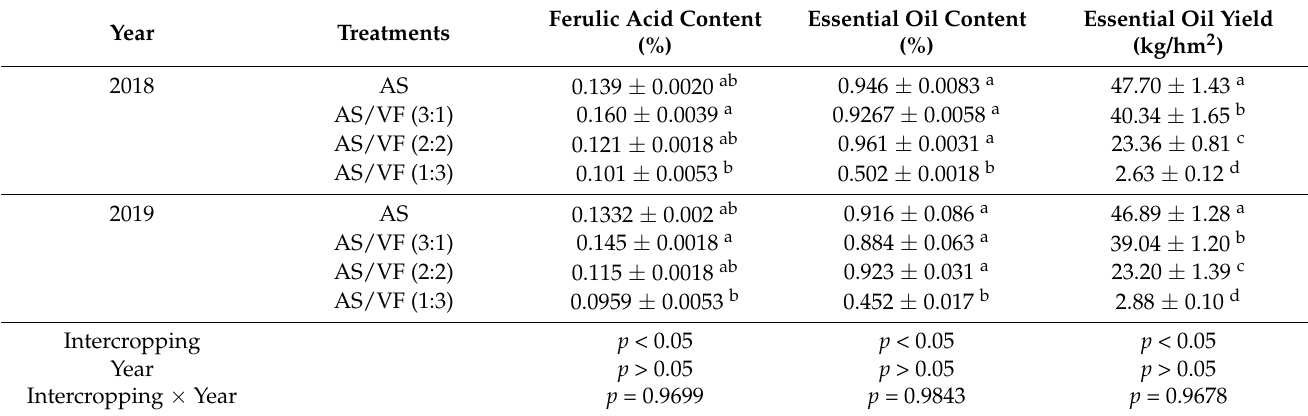
Table 4. Ferulic acid content, essential oil content, and yield of A. sinensis under different cropping systems in 2018 and in 2019 1